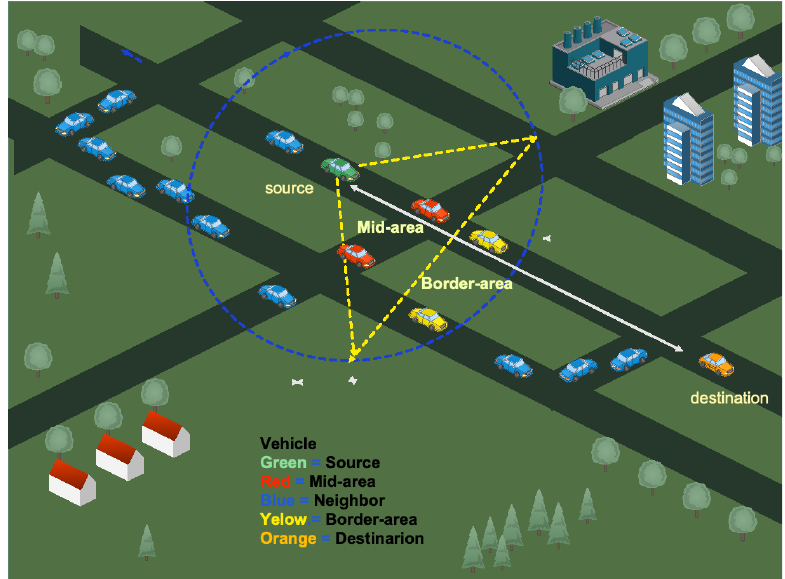
Figure 14. Mid-area and border-area example